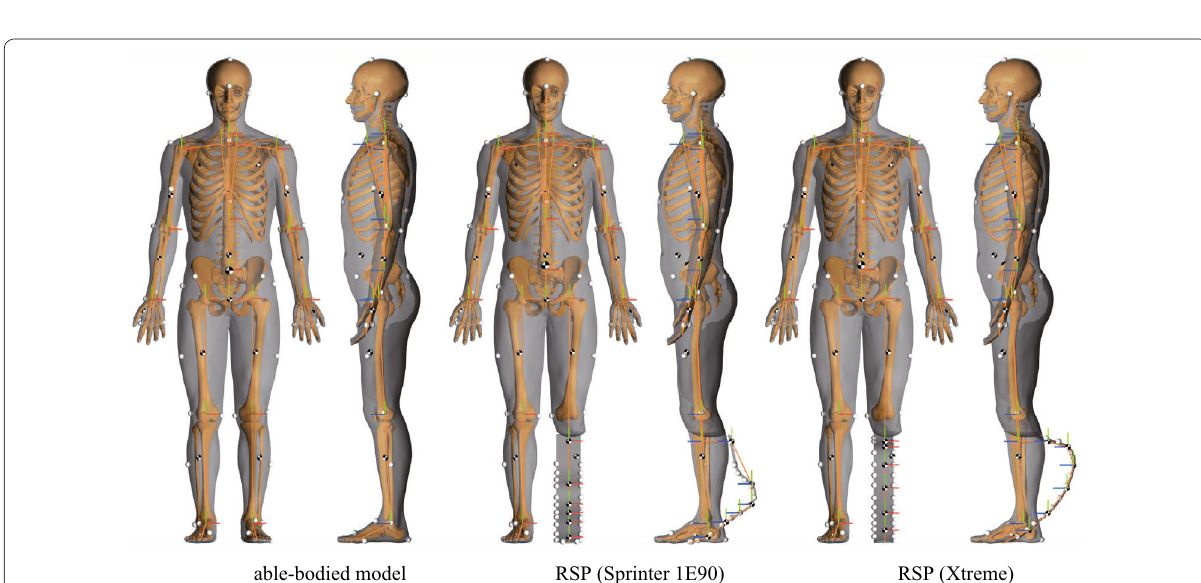
Fig. 2 Digital human models of an able-bodied individual and ILEA fitted with an RSP. Left: digital human model of the able-bodied individual, mid- dle: model of the ILEA fitted with Sprinter 1E90, and right: model of the ILEA fitted with